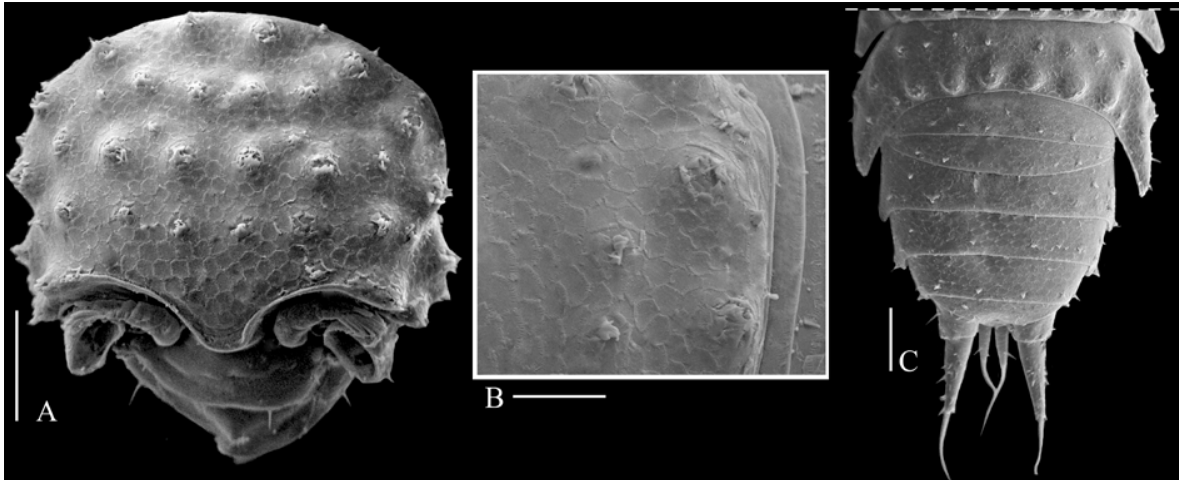
Figure 19. Pectenoniscus morrensis n. sp. Female paratype: A , cephalon, frontal view; B , epimeron 1, dorsal view; C , pleonite 7, pleon, pleotelson and uropods, dorsal view. Scale bar: A, C : 100µm; B : 40µm.